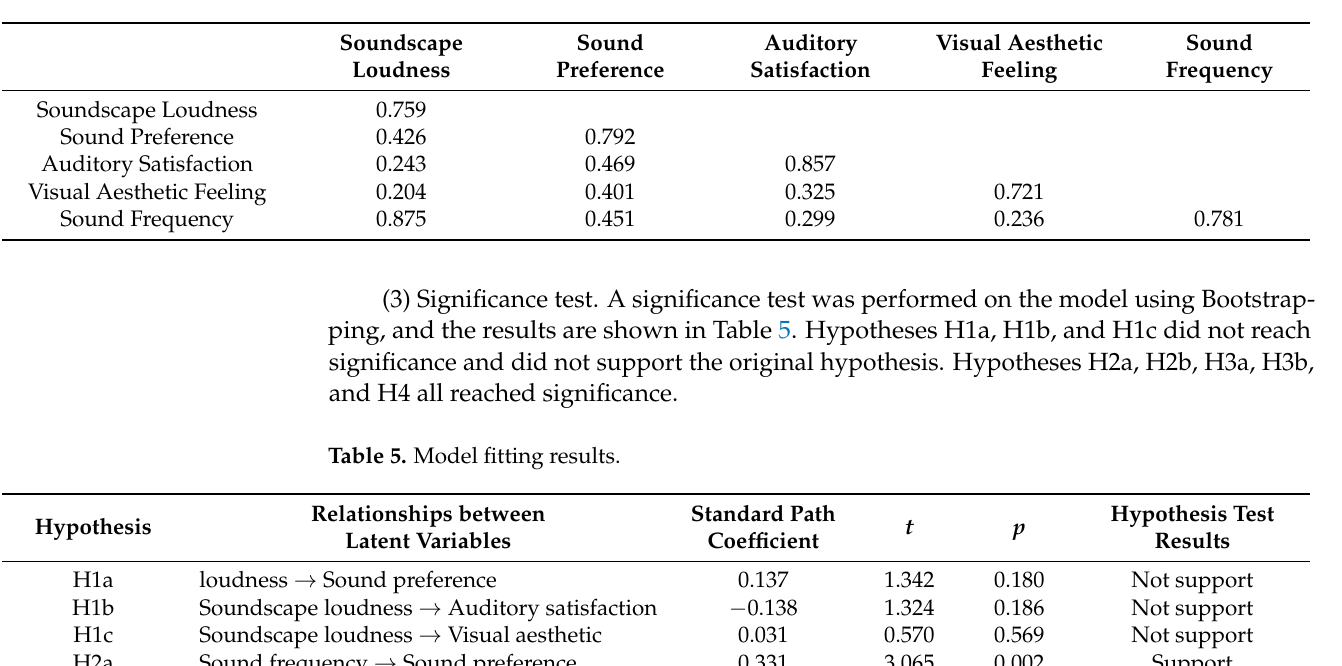
Table 4. Discriminant validity test results.